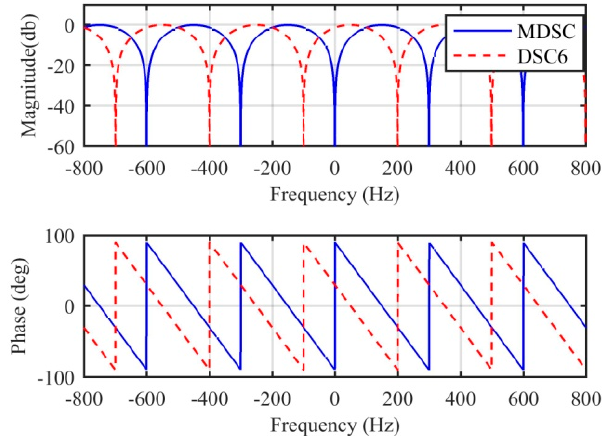
Figure 7. Bode diagram of MDSC (solid lines) and DSC6 (dashed lines).